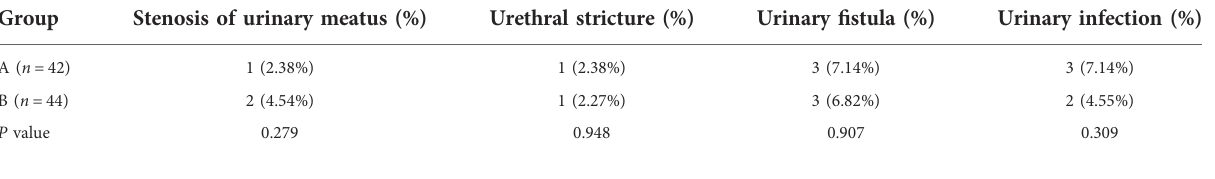
TABLE 1 Complications occurring in the two